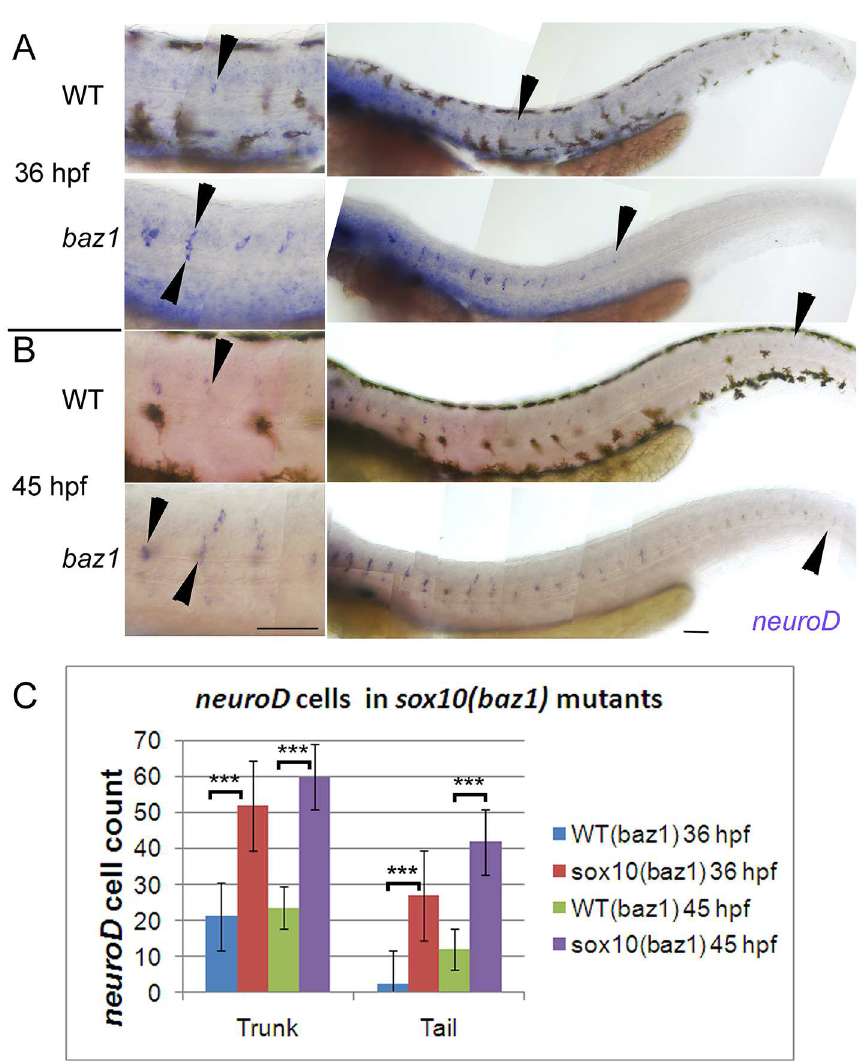
cells) and extendingmore posteriorly(right panels;arrowheadmarks posteriormost neurod1 + DRG) in baz1 mutants comparedwith WT siblings at both 36 and 45 hpf. C) Counts of neurod1 + cells on one side of embryo at 36 and 45 hpf embryos (N = 11 for all conditionsexcept 36 hpf baz1 , where N = 13). baz1 mutants significantly different to WT siblings (Student’s t test; *** , p < 0.0001.In this and all subsequent images, embryos are shown in lateral view with dorsal to the top and anterior to the left, unless otherwisestated. Scale bar, 100 μ